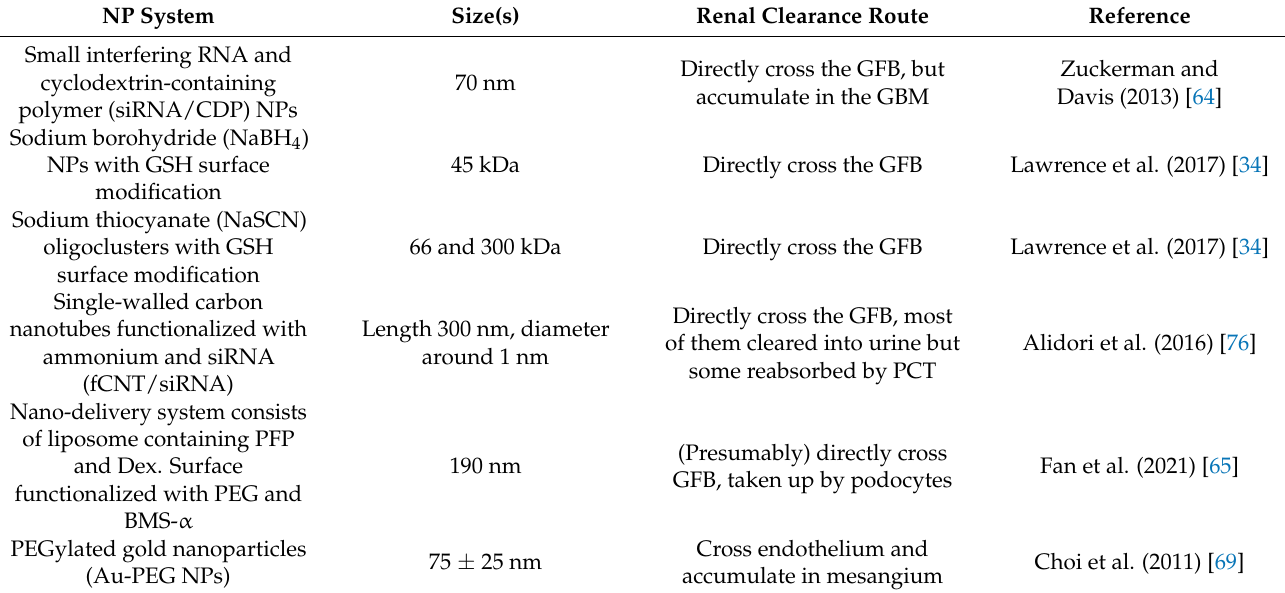
Table 1. A summary of known large NPs which have the ability to either accumulate in certain parts of the kidney or fully experience renal clearance.